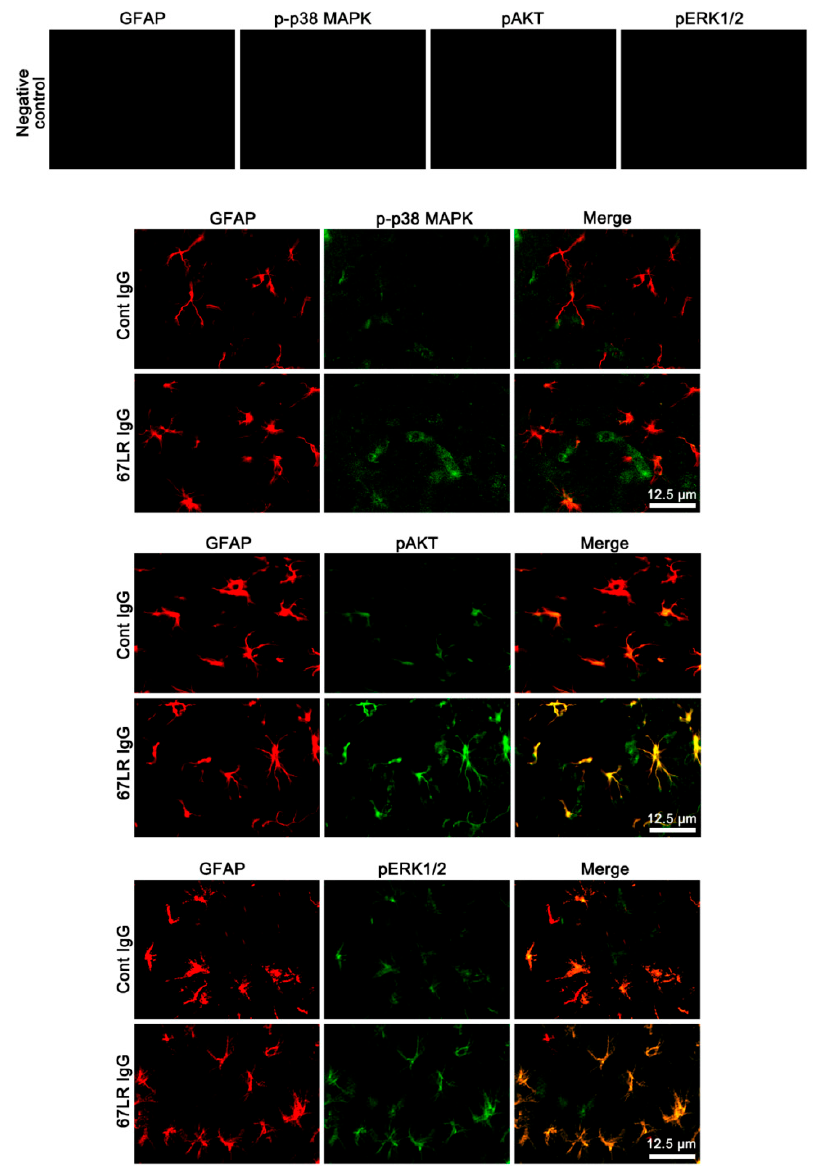
Figure 4. Localizations of p-p38 MAPK, pAKT, and pERK1 / 2 expression in the PC following 67LR neutralization. Up-regulations of pAKT and pERK1 / 2 expression are observed in astrocytes following 67LR IgG infusion. However, the p-p38 MAPK signal is rarely detected in astrocytes.